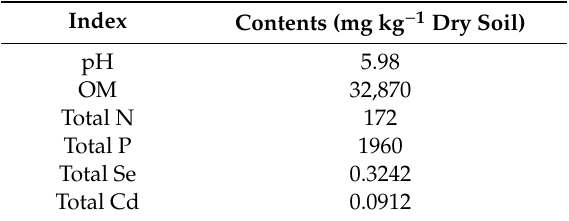
Table 1. The basic physicochemical properties of test